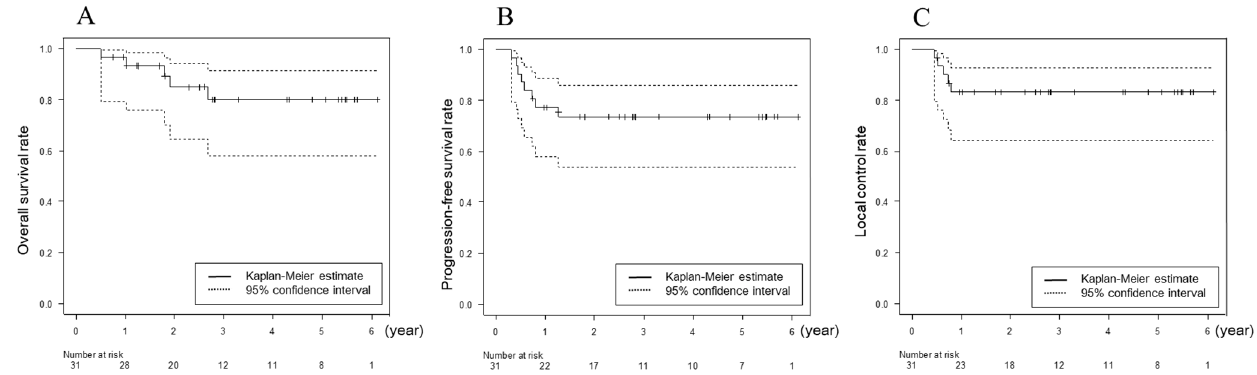
Figure 3. ( A ) Overall survival, ( B ) progression-free survival, and ( C ) local control rates analyzed by the Kaplan–Meier method.